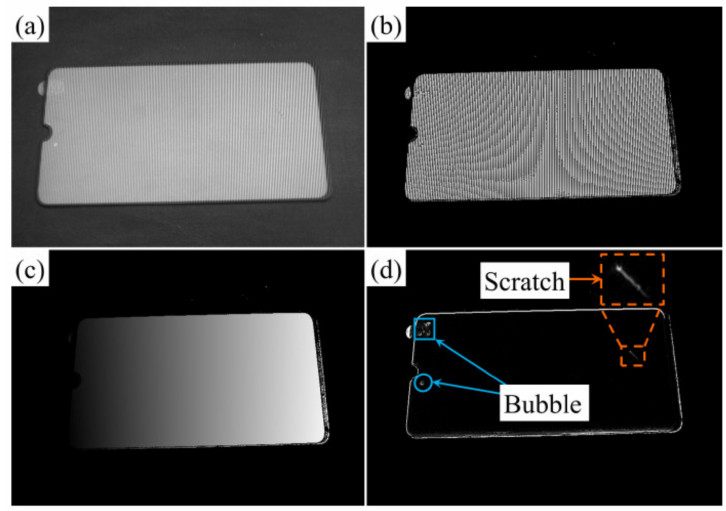
Figure 11. Process of mobile phone glass cover algorithm. ( a ) Sinusoidal fringe, ( b ) wrapped phase, ( c ) absolute phase and ( d ) detection